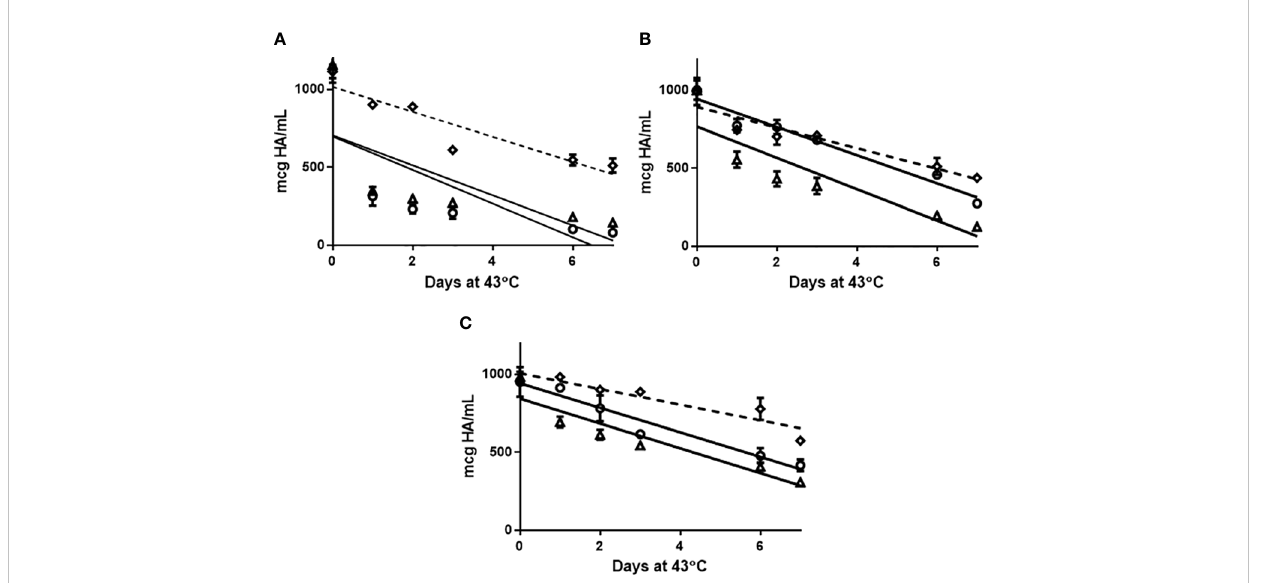
FIGURE 3 A fl uria ® drug substance representing 2015 NH strains: A/California/07/2009 H1N1 (A) , A/South Australia/55/2014 H3N2 (B) and B/Phuket/3073/2013 B Yamagata (C) were held at 43°C for 7 days. Aliquots were removed at days: 0, 1, 2, 3, 6 and 7 and assessed for potency by monoclonal ELISA (circle), SRID (triangle) and polyclonal ELISA (Diamond). Slope comparison determined by linear regression modelling was plotted (slope full line: mAb ELISA and SRID, slope broken/dash line: pAb ELISA) and assessed in results section. Error bars represent standard deviation between assay replicates.